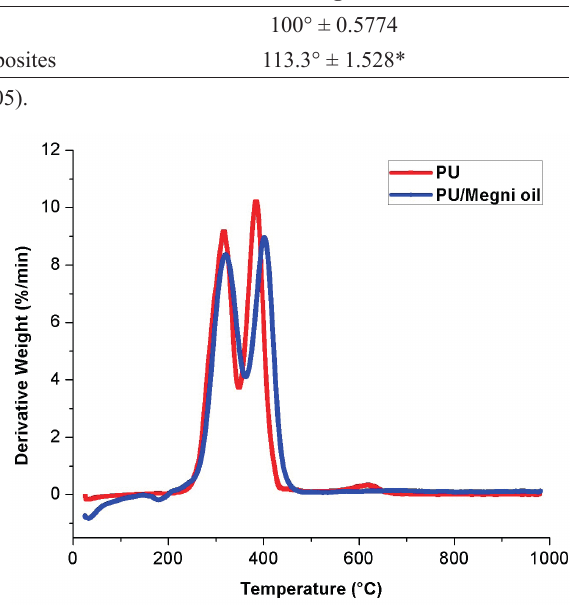
Figure 4 - Weight residue percentage of PU membrane and PU/Megni oil nanocomposites.